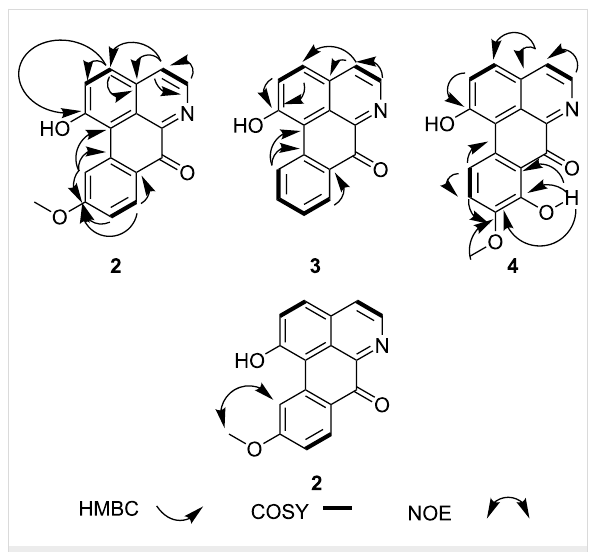
Figure 2: COSY, HMBC and NOE correlations of compounds 2 , 3 and 4 .